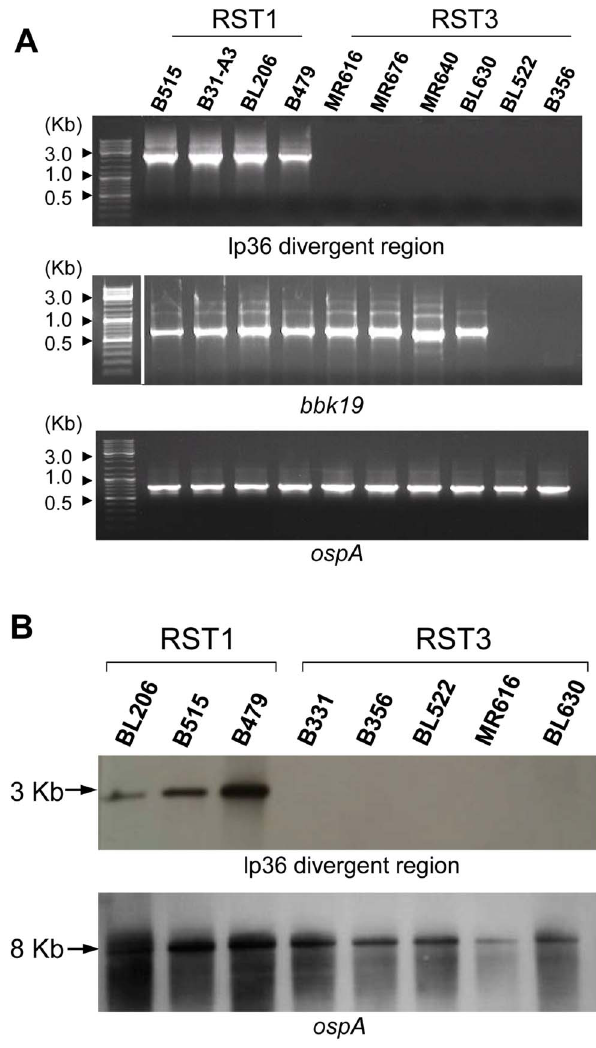
Figure 6. RST1 isolates contain a region of lp36 that is lacking in RST3 isolates. RST1 and RST3 B. burgdorferi isolates were grown to late log phase prior to isolation of plasmid DNA. ( A ) PCR primers were designed to amplify a , 2.5 kilobase region on the distal end of lp36. The presence of lp36 was assessed by amplification of bbk 19, an ORF located adjacent to the plasmid partition locus. PCR products were analyzed by gel electrophoresis in 1% agarose gels prepared in 1X TBE buffer and stained with ethidium bromide. ( B ) Southern blotting of Spe I digests of total genomic DNAs of B. burgdorferi isolates was performed using a probe specific for the variable region of lp36 (upper panel). As a control, membranes were stripped and re-probed for B. burgdorferi ospA (BBA15), located on lp54 (lower